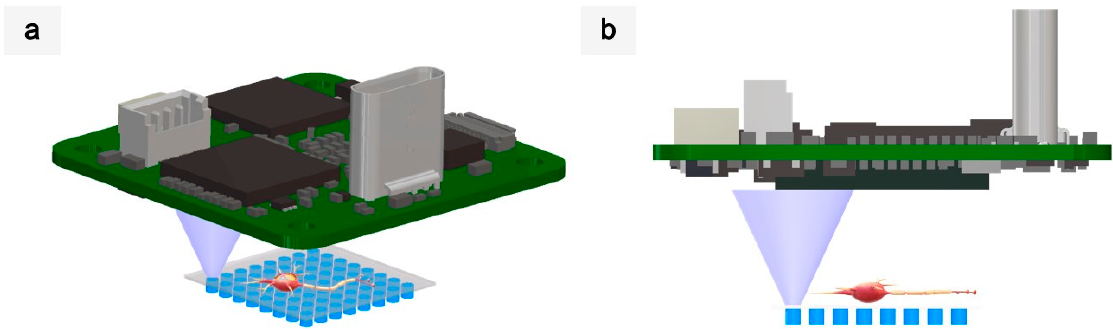
Figure 1. Schematic diagram of electronic scanning transmission optical microscopy. ( a ) Perspective view. ( b ) Side view.